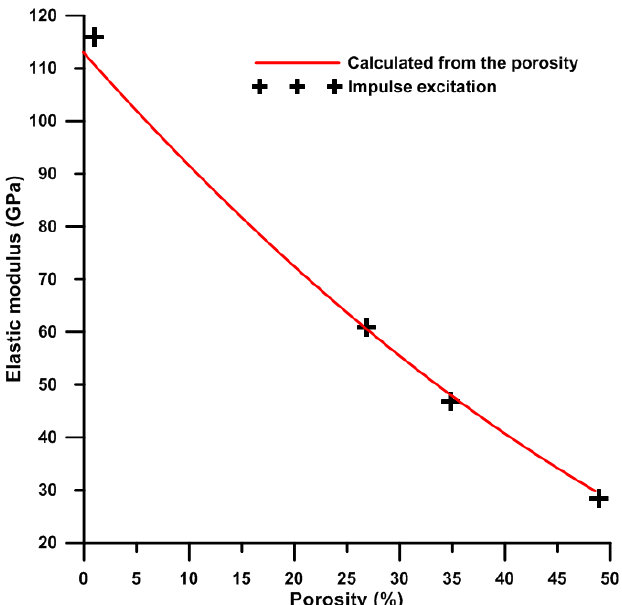
Figure 9. The dependence of Young´s modulus (calculated and experimental determined) on porosity of titanium.